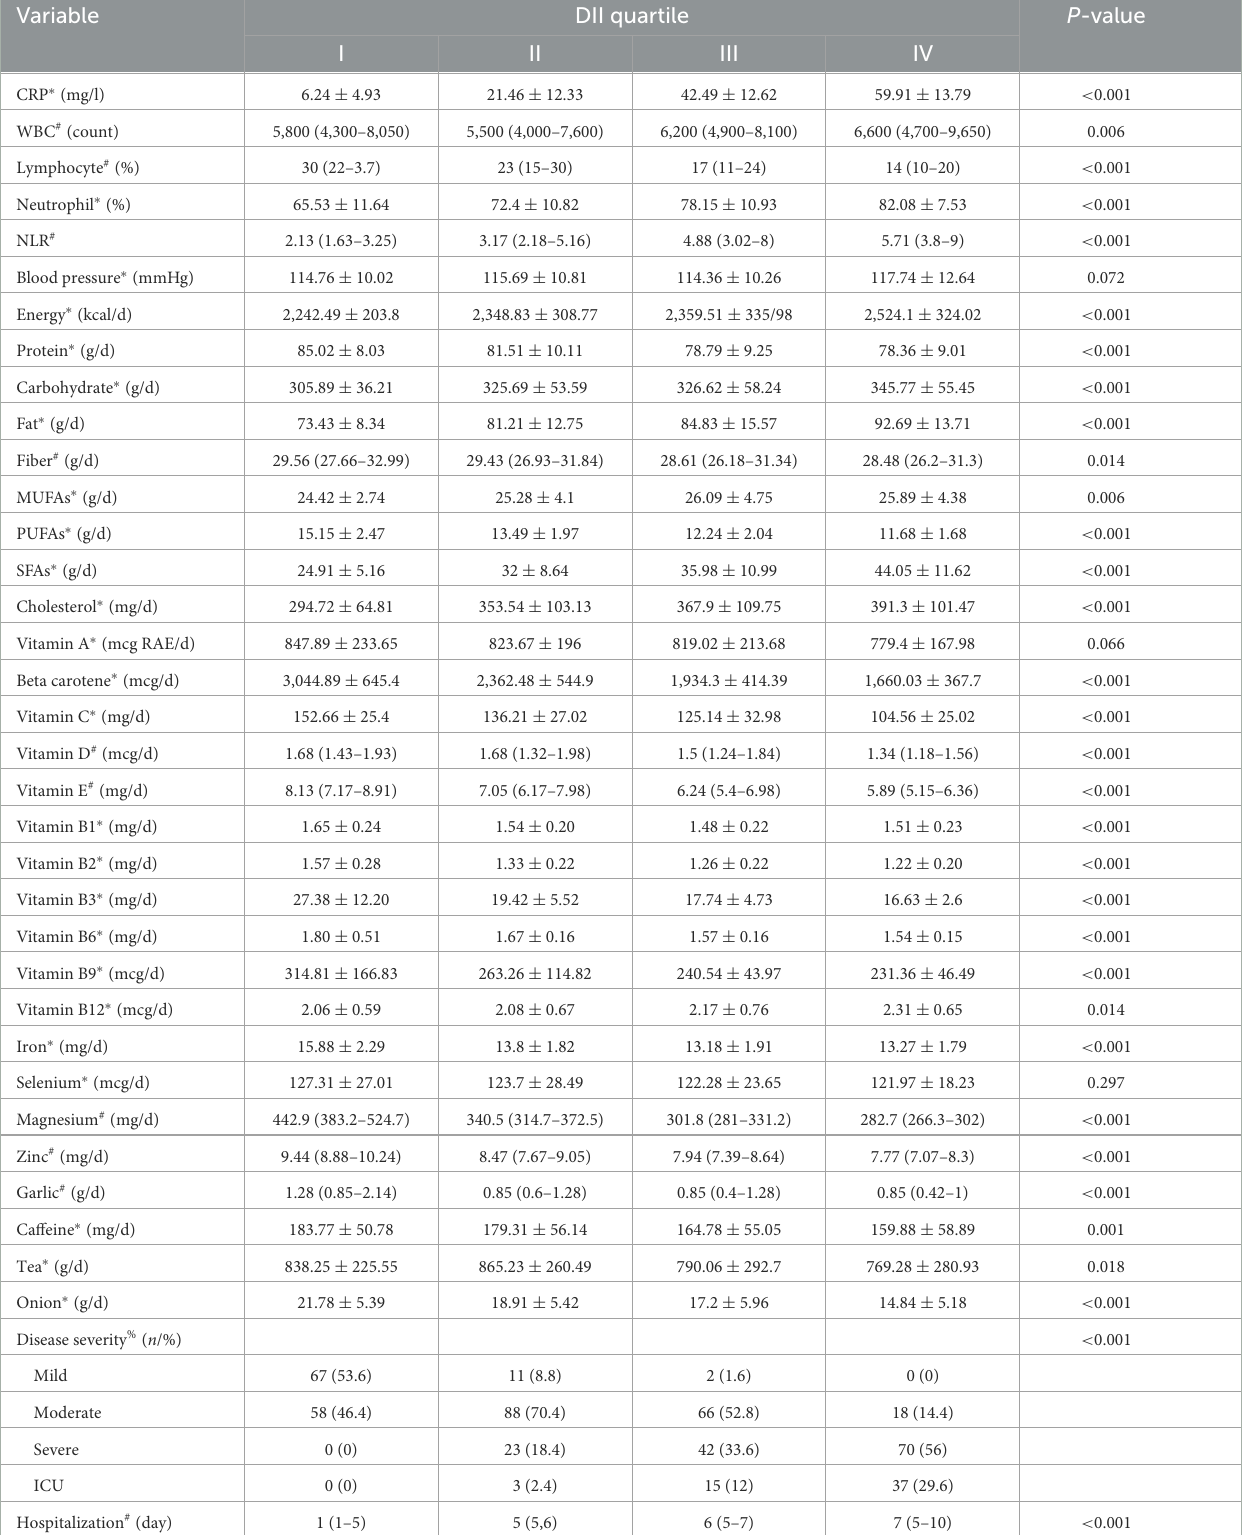
TABLE 2 Biochemical measures, dietary factors, and disease severity among patients with different DII quartiles.